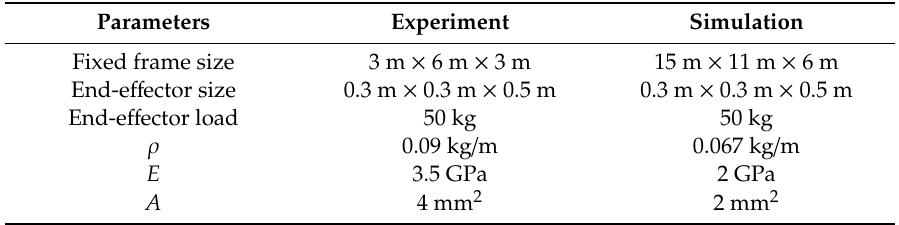
Table 1. Parameters of CDPMs used in experiment and simulation.